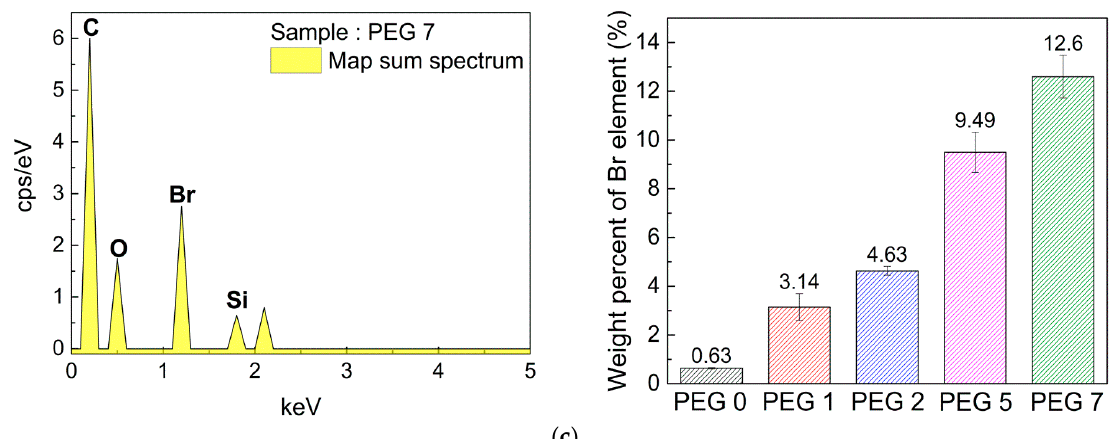
Figure 5. ( a ) Change in the surface roughness after the amine-epoxy ring opening reaction and ( b ) the distribution of Br (Br mapping) on the surface of hydrogel films with varying G-SiNP contents. ( c ) Integrated area spectra and wt% of Br on various crosslinked films with varying G-SiNP contents obtained by FESEM–EDS.